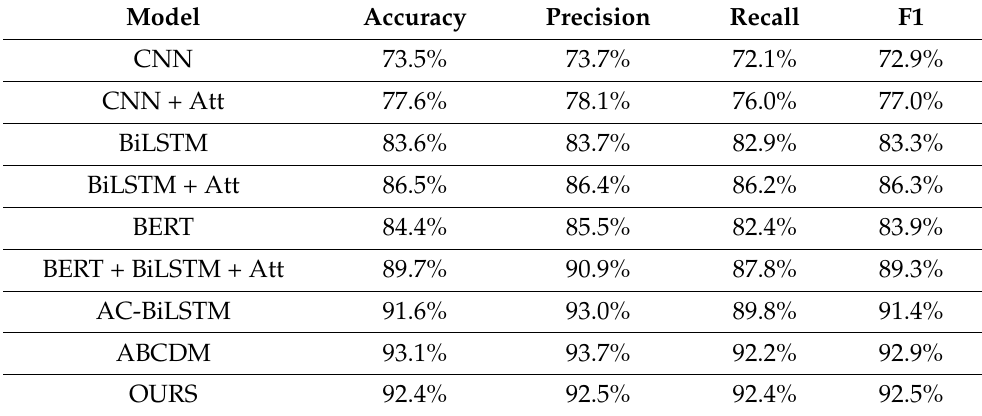
Table 6. Comparison model experiment